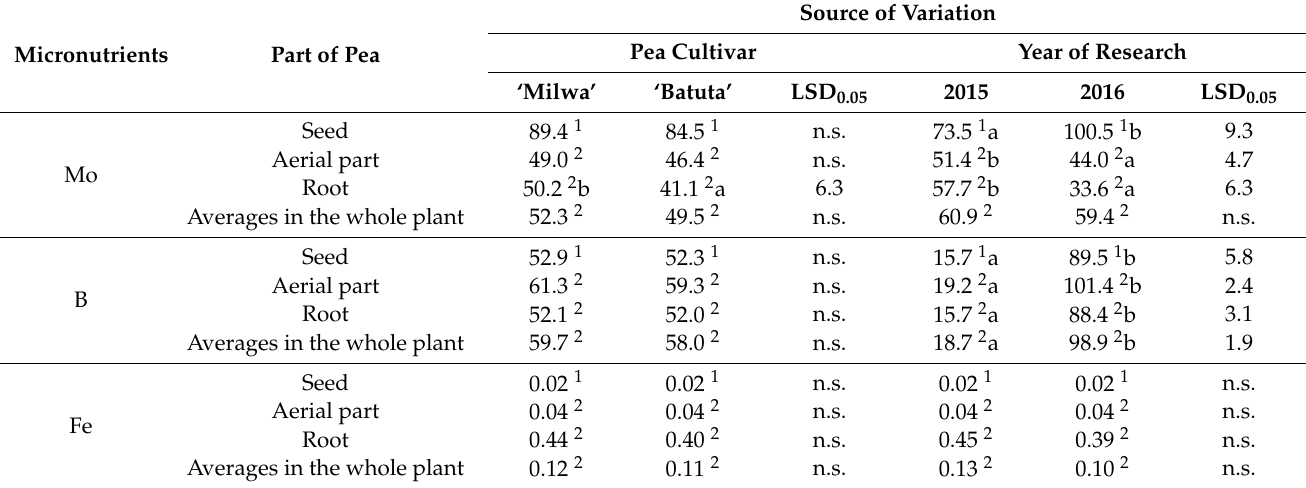
Table 8. Bioaccumulation factors of Mo, B, and Fe in pea.